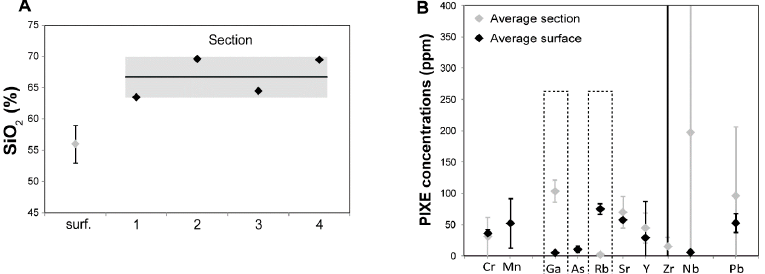
Figure 6. Main PIXE results for a piece of shale/sandstone (13716): comparison between the surface and the section. ( A ) Results for the major element Si. Diamonds in light gray: average with standard deviation calculated from three measures on the surface. Diamonds in black: inside of the section. The black line represents the average from the measurements on the section and the gray area the standard deviation. ( B ) Results for trace elements (average and standard deviation only).